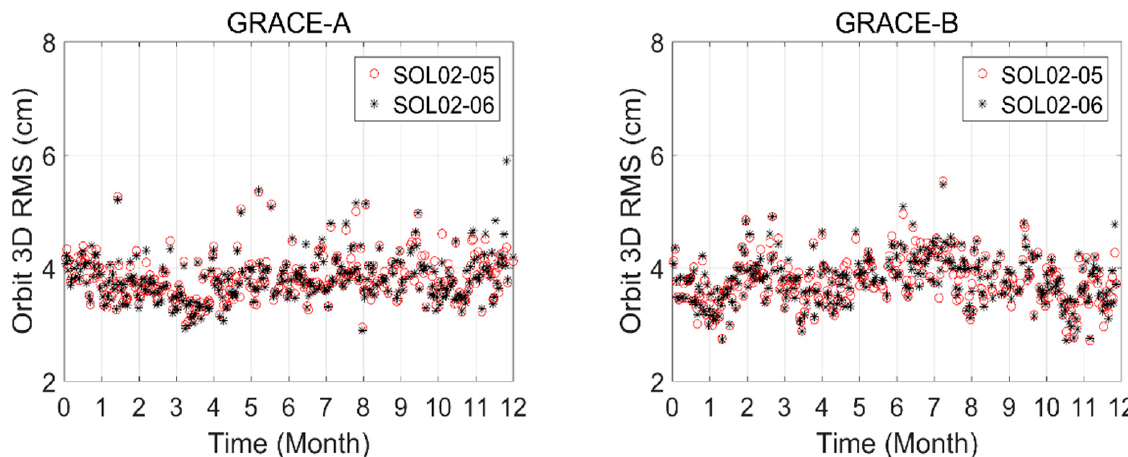
Figure 6. 3D RMS of GRACE-A/B orbits from SOL02 determined using different AOD1B models (RL05 and RL06).